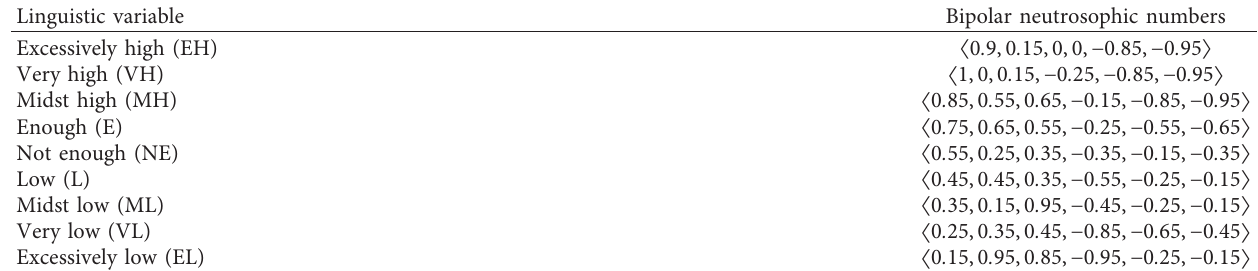
Table 1: The linguistic variable under bipolar neutrosophic numbers.